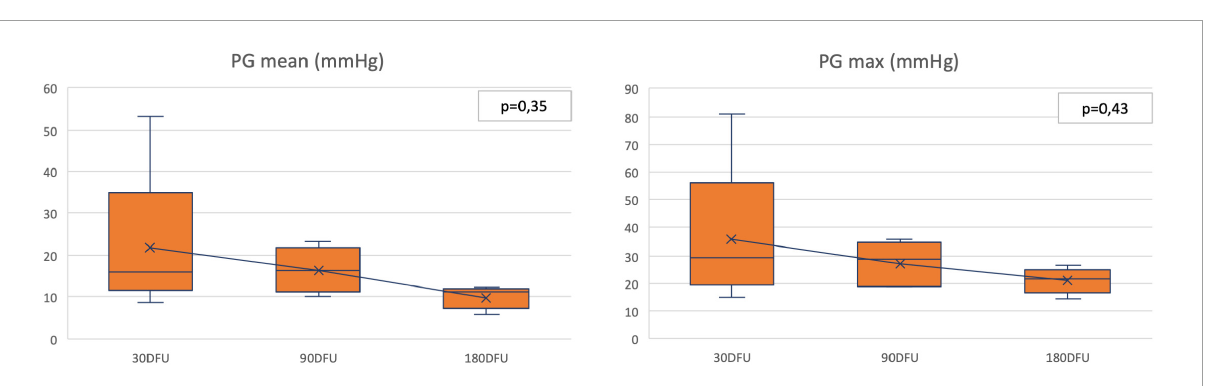
FIGURE5 Pressure gradients—serial measurements. DFU: days follow-up; PG: pressure